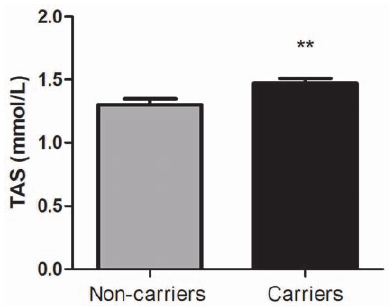
Figure 1. Total antioxidant status in plasma. Total antioxidant status (TAS) in plasma of TP53 p.R337H carriers (n=16) and non-carriers (n=16). Data represent mean 6 S.E.M (**) P , 0.01 (Student t Test for unpaired samples). Figure 2. Malondialdehyde (MDA) levels in plasma. Malondial- dehyde (MDA) levels in plasma from TP53 p.R337H mutation carriers (n=16) and non-carriers (n=16). Data represent the mean 6 S.E.M, (***) P , 0.0001 (Student t Test for unpaired samples).